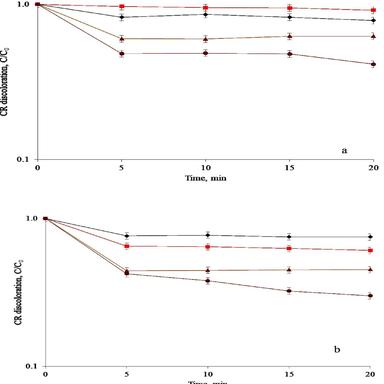
Congo Red discoloration using different zeolite materials: (■) Fe1.0HAlBEA, (◆) Fe1.0SiBEA, (●) Fe4.0HAlBEA, and (▴) Fe4.0SiBEA at different zeolite loads: (a) 80 and (b) 160 mg L− 1 and 50 mM H2O2. (For interpretation of the references to color in this figure legend, the reader is referred to the web version of this article.)